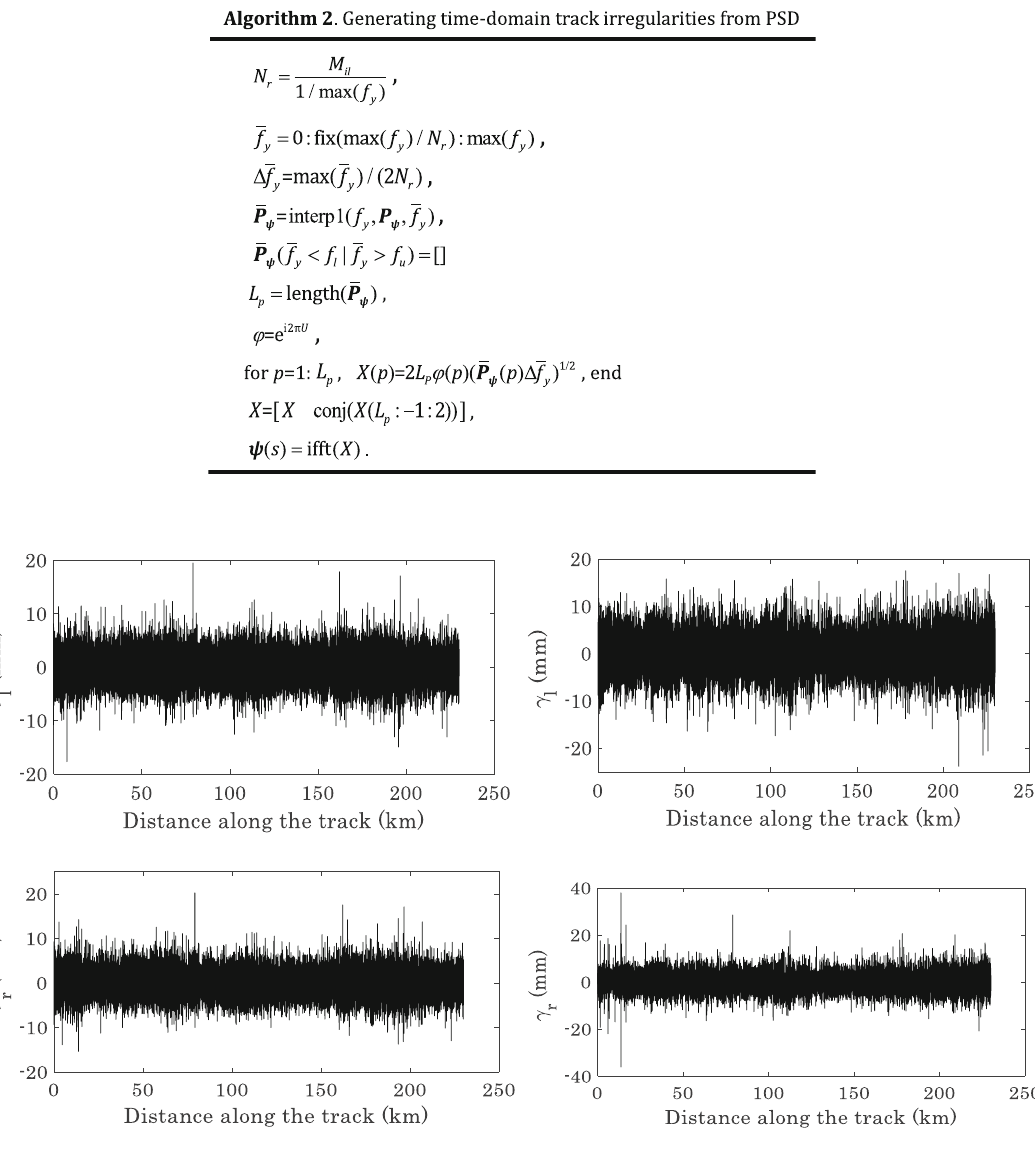
Fig. 3 The measured track